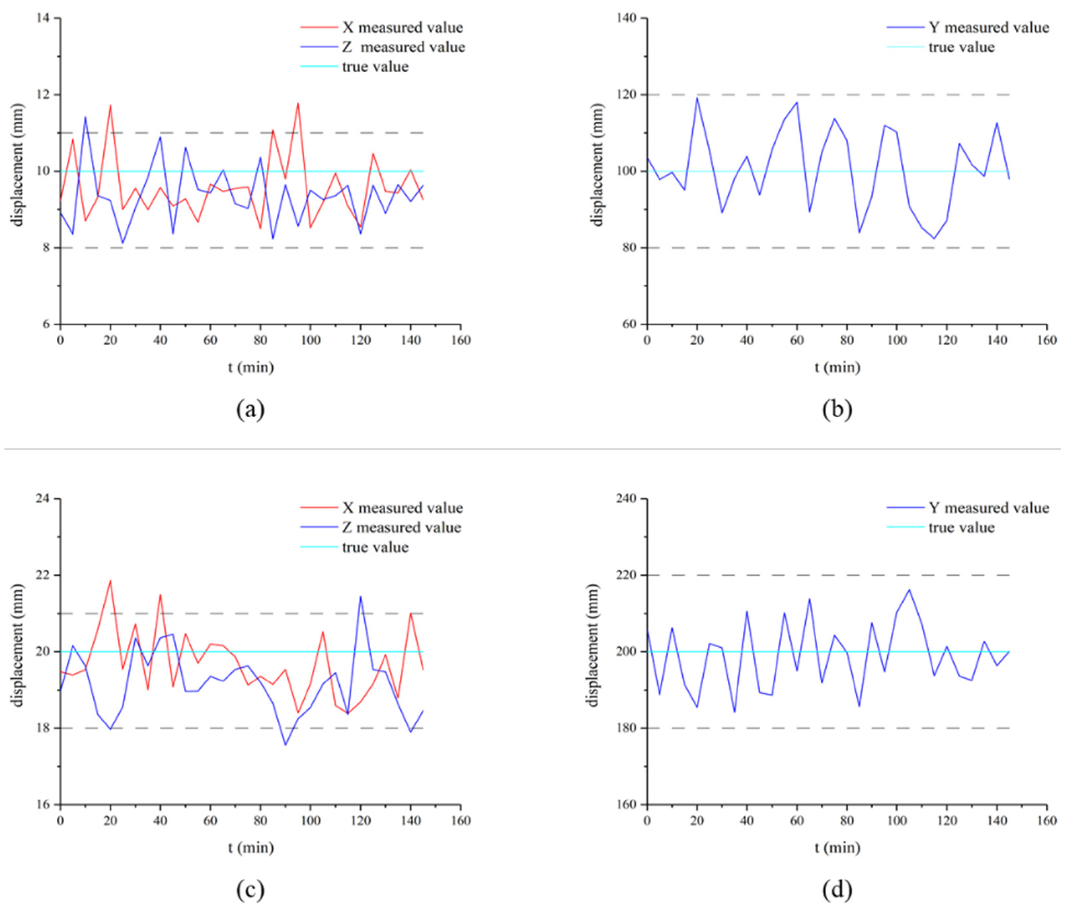
Figure 9. Calculation results upon camera movement. ( a ) The result of the landmark moving 10 mm in X and Z axes. ( b ) The result of the landmark moving 100 mm in Y axes. ( c ) The result of the landmark moving 20 mm in X and Z axes. ( d ) The result of the landmark moving 10 mm in Y